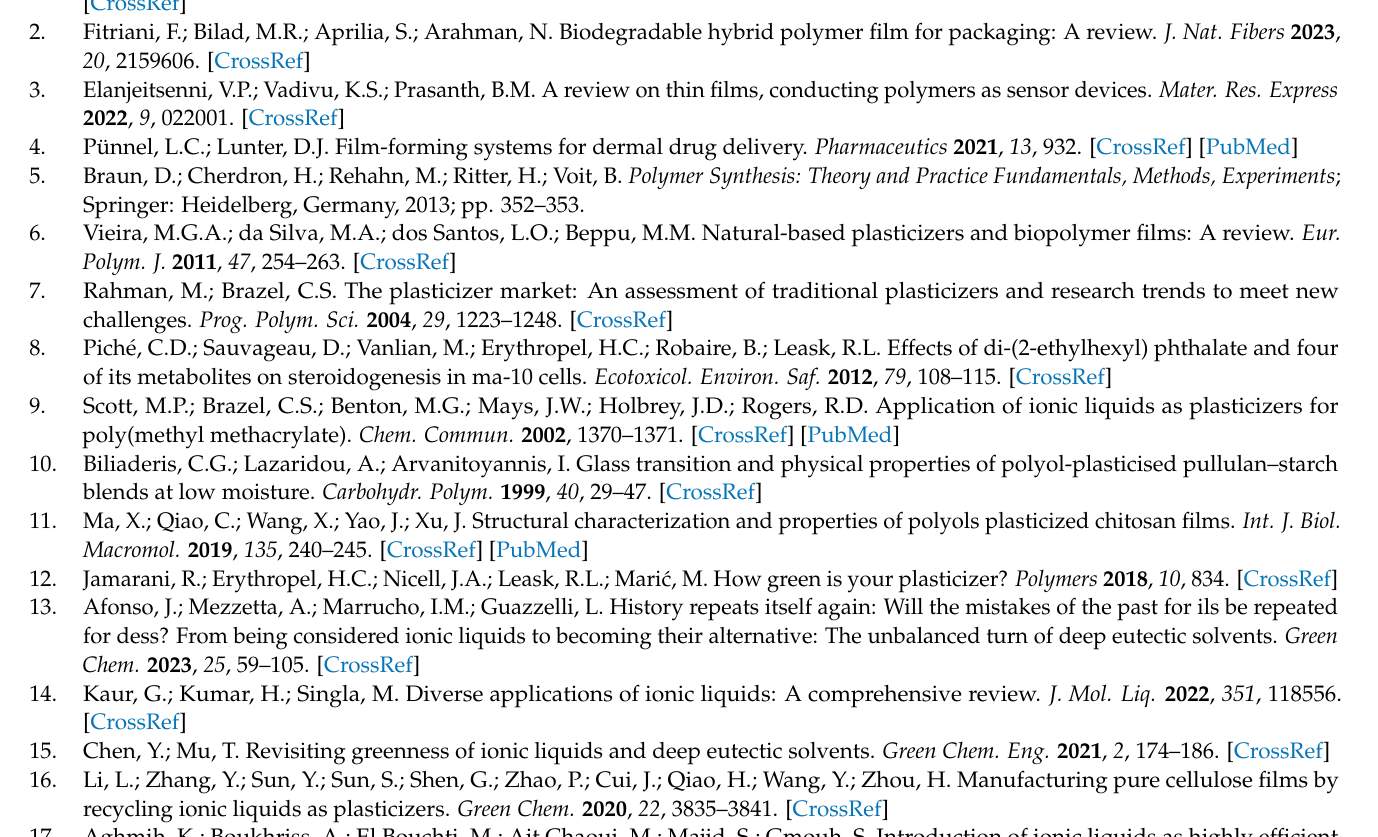
Figure S3: 10% [HMIM]Cl; Figure S4: 10% DOP and [HMIM]Cl blend; Figure S5: 10%